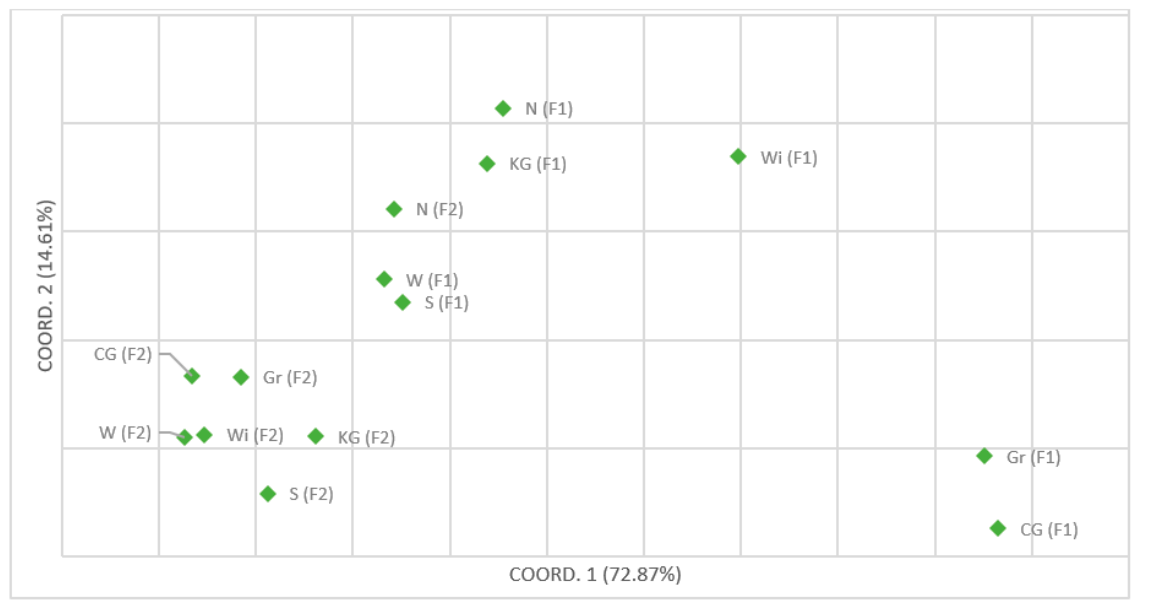
Figure 3. Grouping of studied Scot pine locations using principal coordinates analysis (PCoA) based on Nei genetic distance [32].